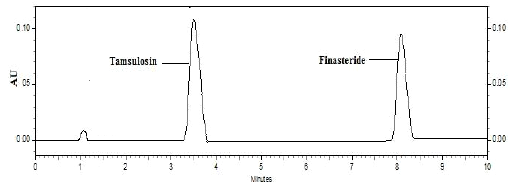
Figure 4. Chromatograms of tamsulosin and finasteride test sample.